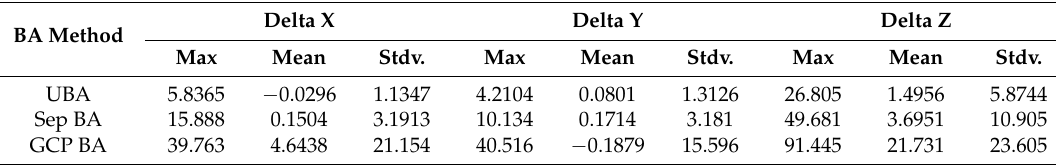
Table 1. Check points coordinates difference (pixels).